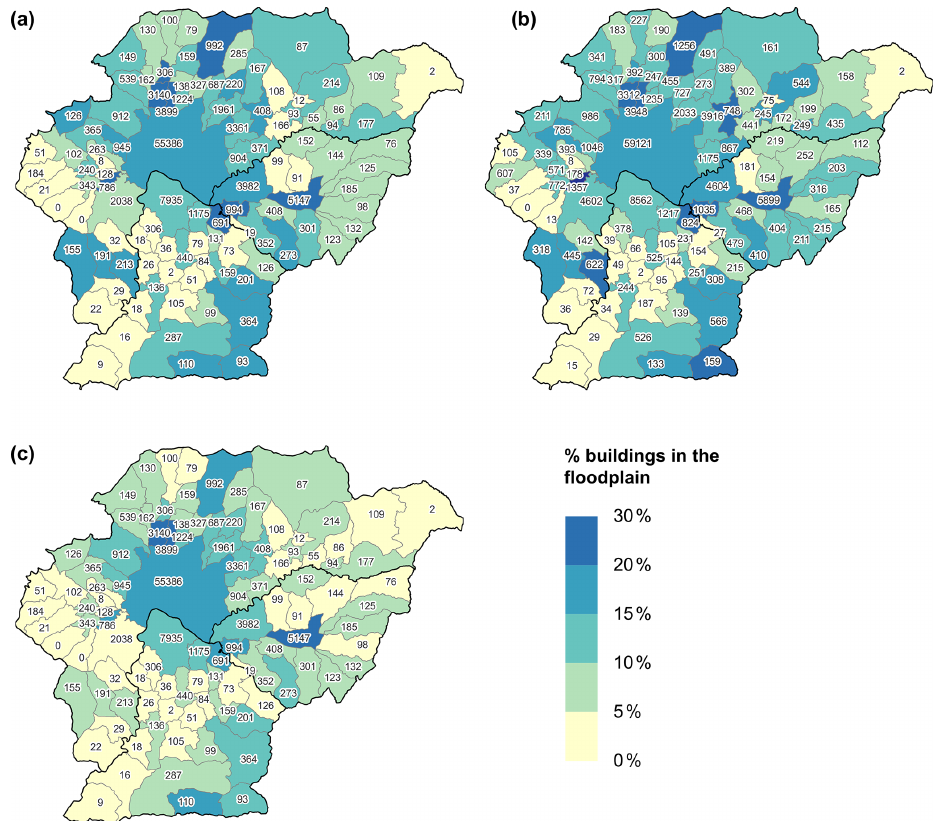
Figure 7. Spatial distribution of buildings in the 100-year floodplain for (a) Scenario A, (b) Scenario B, and (c) Scenarios C and D. The numbers plotted inside each municipality correspond to the expected number of buildings in the